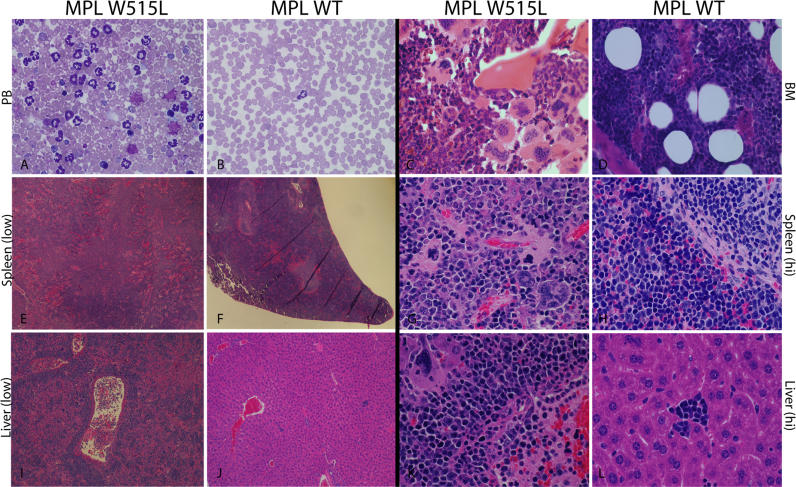
MPLW515L and MPLWT Bone Marrow Transplant Model HistopathologyHistology of MPLW515L-transduced and MPLWT-transduced Balb/C mice showing images of peripheral blood (A and B) and histopathology in representative sections of bone marrow (C and D), spleen (E–H), and liver (I–L). Peripheral blood smear (B) (600×, Wright-Giemsa) of a representative MPLWT animal displays an unremarkable white blood cell and platelet count. In contrast, peripheral blood smear (A) (600×, Wright-Giemsa) of a representative MPLW515L mutant animal reveals marked thrombocytosis and leukocytosis comprising a predominant population of maturing myeloid cells as well as frequent nucleated erythroid forms. Bone marrow images from MPLWT animals display preserved marrow architecture with maturing trilineage hematopoiesis (D) (600×, hematoxylin and eosin [H&E]). Comparatively, bone marrow sections from MPLW515L mutant animals demonstrate marrow elements comprising a prominent population of maturing myeloid cells with increased numbers of megakaryocytes including atypical and dysplastic forms occurring in frequent clusters (C) (600×, H&E) and showing emperipolesis of neutrophils in megakaryocyte cytoplasm. Spleen sections from MPLW515L mice display complete effacement of normal splenic architecture (E) (40×, H&E) with a marked expansion of red pulp that is composed of an admixture of maturing myeloid and erythroid elements and numerous numbers of atypical megakaryocytes (G) (600×, H&E) compared with MPLWT spleens (F and H) (40× and 600×, H&E), which display a relative preservation of normal spleen architecture and the presence of only maturing erythroid forms in the red pulp. Liver images from MPLW515L mice illustrate evidence of extensive extramedullary hematopoiesis in a perivascular and sinusoidal distribution (I) (100×, H&E) composed predominantly of a population of maturing erythroid elements with frequent large atypical megakaryocytes and occasional admixed myeloid forms (K) (600×, H&E). In comparison, only small, focal areas of nucleated erythroid cells were observed in livers from MPLWT animals (J and L) (100× and 600×, H&E).